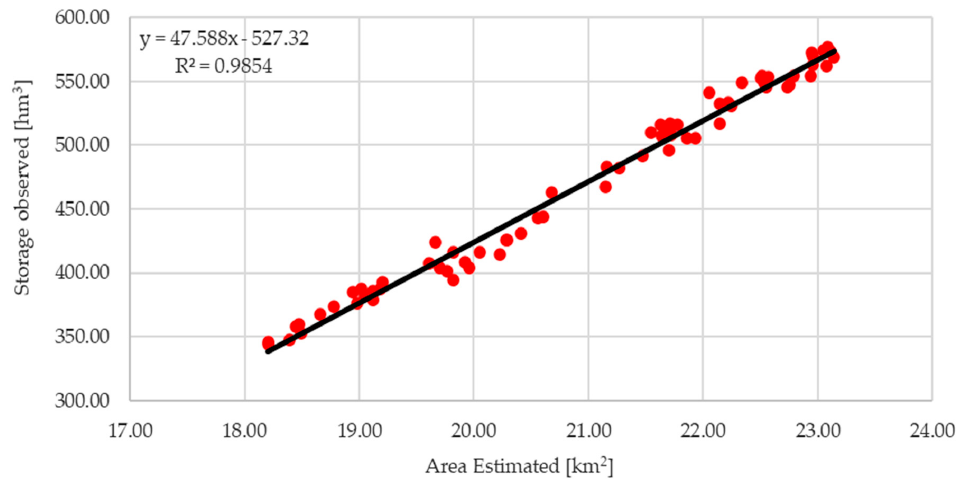
Figure 5. Yliki reservoir water area and storage linear relationship.